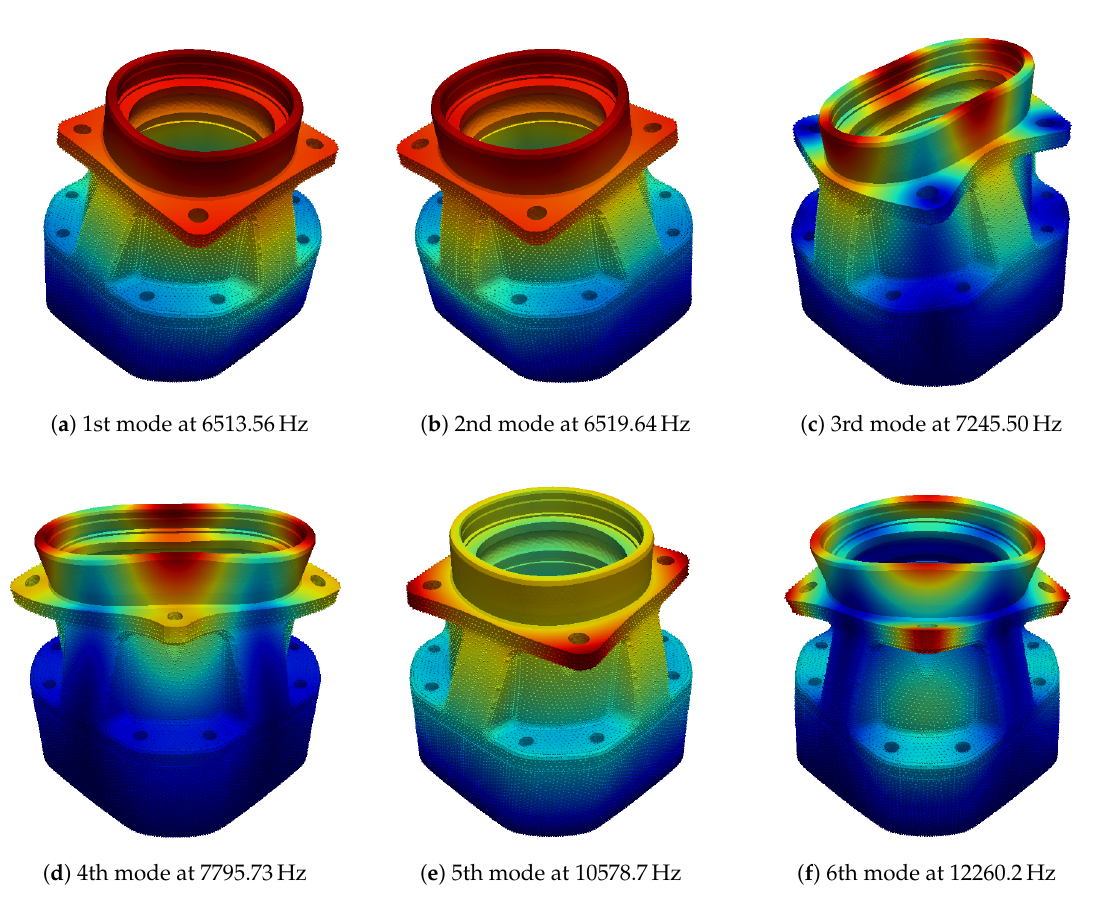
Figure 9. First six mode shapes of the gear